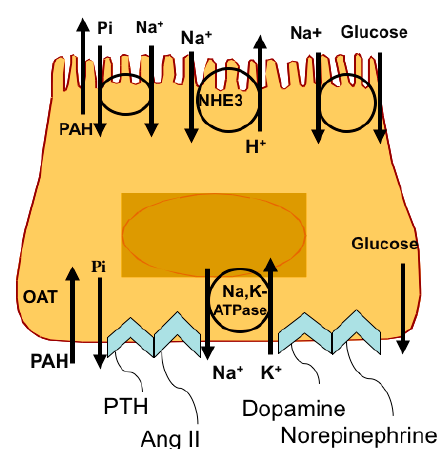
Figure 7. Primary RPT cells have a polarized morphology with an apical surface facing the medium in vitro and a basolateral surface facing the culture dish. The cultures possess a Na + /Pi cotransport system (NaPi2a), a Na + /H + antiport system (NHE3), and a Na + /glucose cotransport system (SGLT2) on the apical surface, facilitating Na + , Pi, and glucose reabsorption. The Na + gradient required for reabsorption is provided by the basolateral Na + ,K + -ATPase, which is also is responsible for the efflux of Na + into the interstitial space. The RPT cells also have a basolateral p-AH transport system responsible for the secretion of organic anions into the lumen of the nephron. The primary RPT cells also have receptors for PTH, Ang II, dopamine, and norepinephrine.